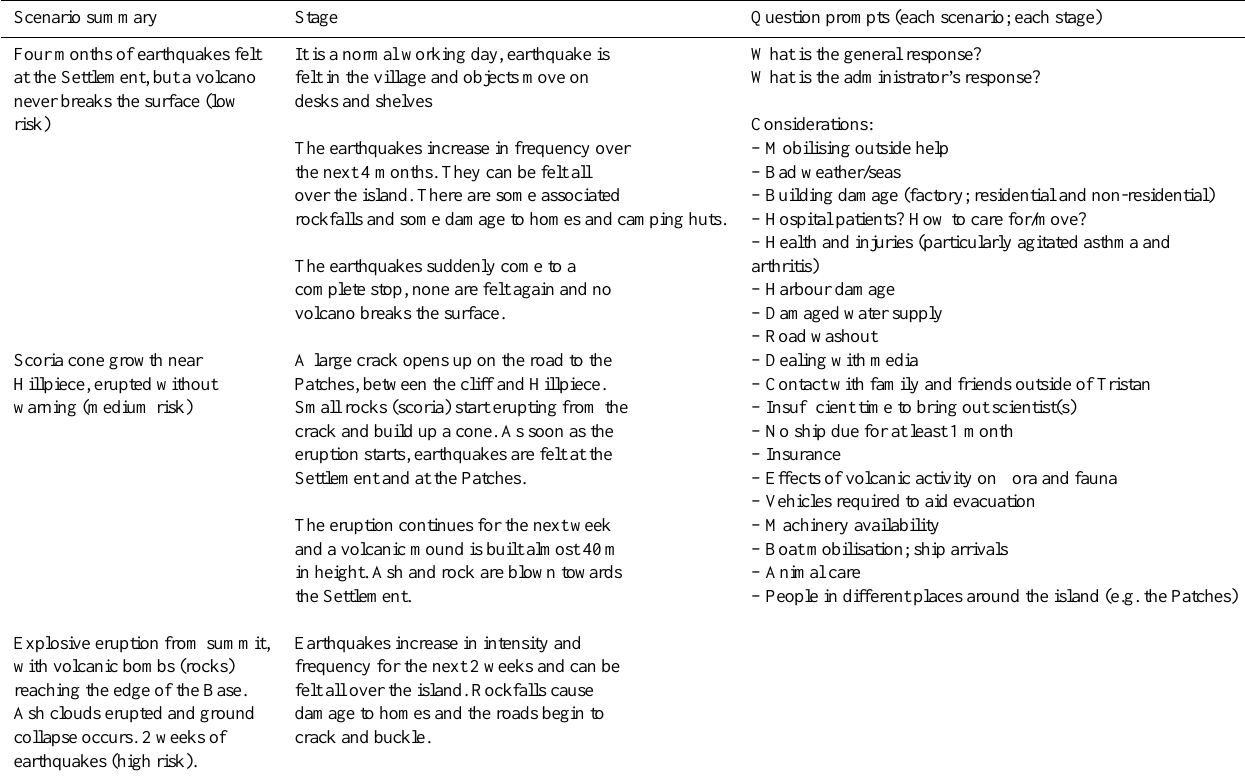
Table 5. Scenarios chosen for discussion. Stages of each scenario are outlined (separations indicate pauses for discussion). Questions and a list of considerations, discussed at each stage, are